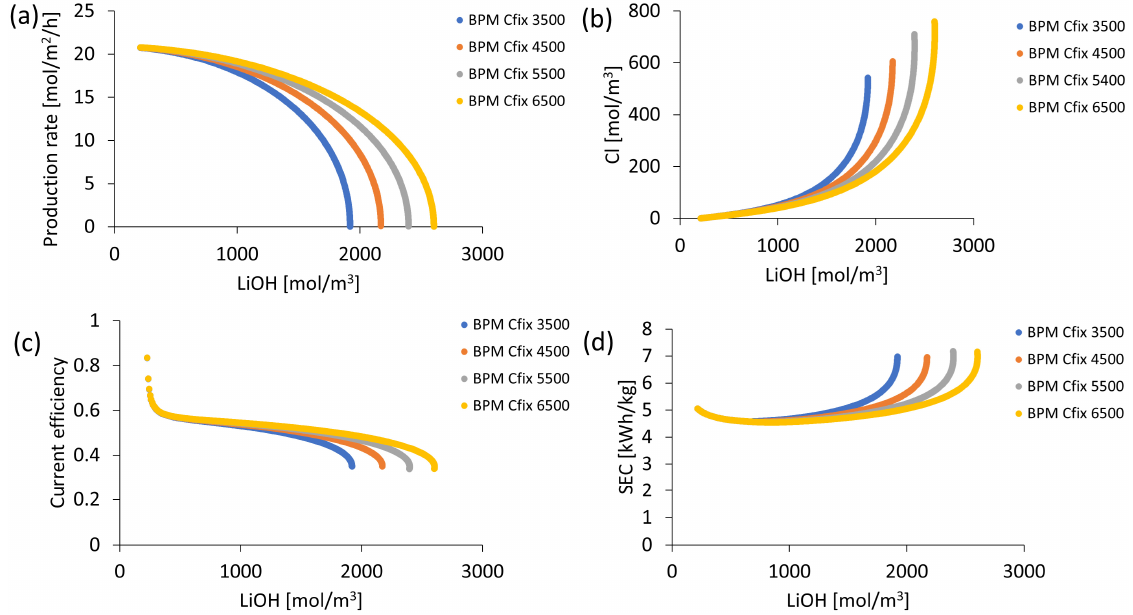
Figure 4. Process performance according to fixed charge density in the bipolar membrane: ( a ) LiOH production rate; ( b ) Cl − concentration; ( c ) Current efficiency; ( d ) Specific electricity consumption (SEC).